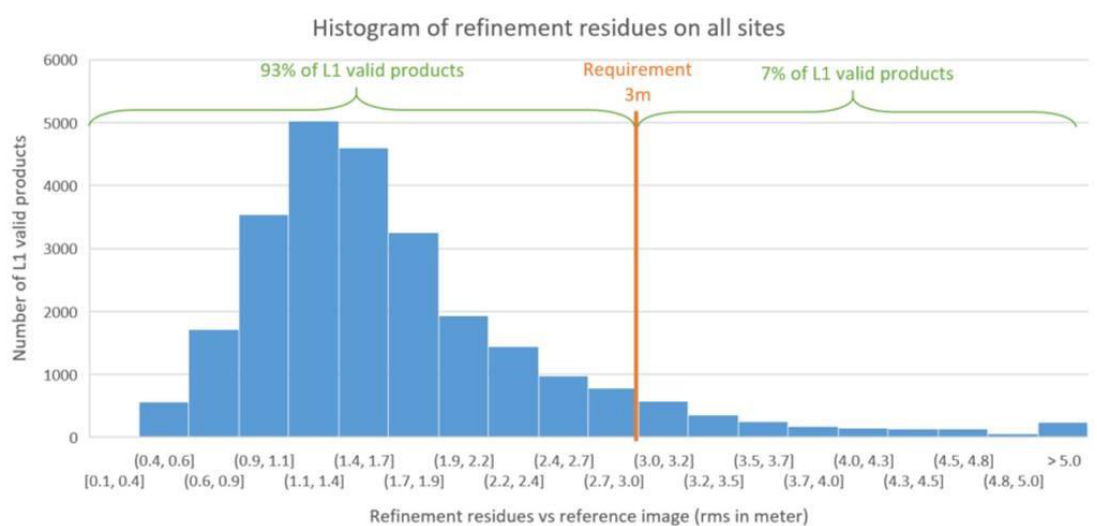
Figure 24. Distribution of multi-temporal registration performances. Results on all valid products between May 2019 and May 2020.